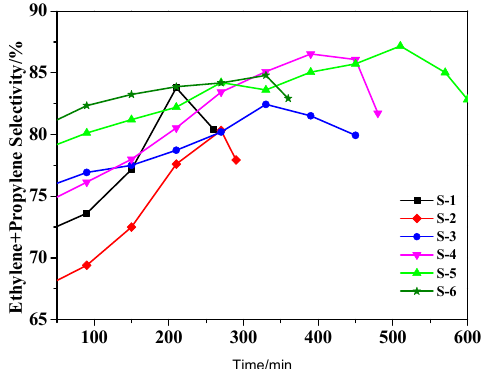
Figure 8. The ethylene and propylene selectivity of the MTO reaction on SAPO-34 samples at 723 K and a WHSV of 3 h − 1 .